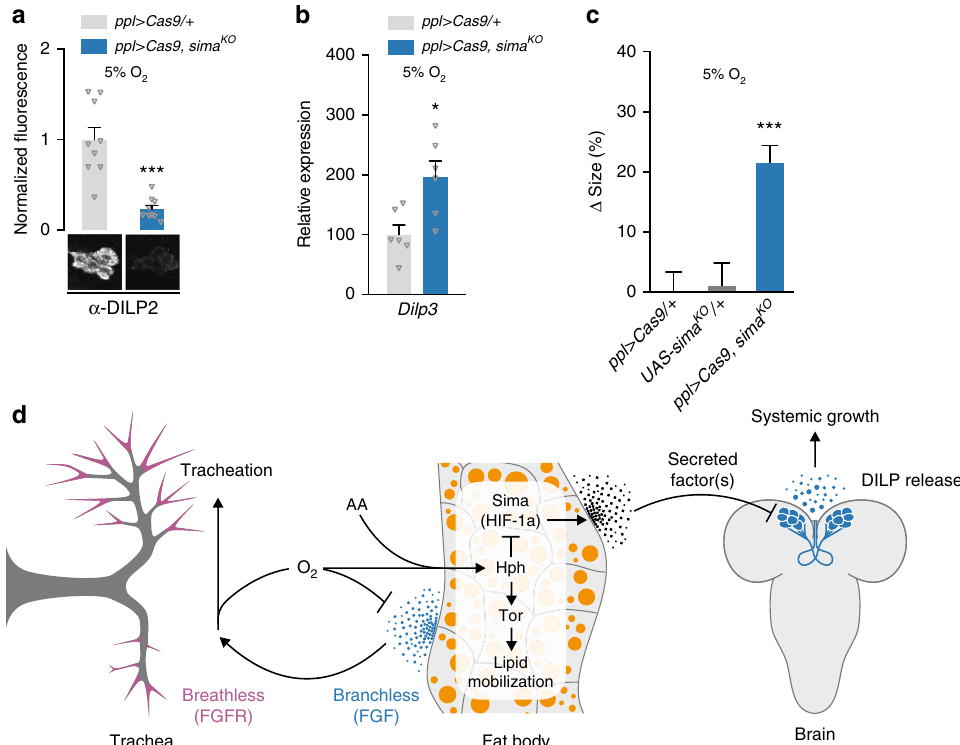
Fig. 8 HIF-1a/Sima is required in the fat body for hypoxia-induced growth suppression. a – c Fat-body-speci fi c loss of sima via tissue-speci fi c CRISPR/Cas9- mediated gene disruption reduces hypoxia-induced IPC DILP2 retention ( a ) and suppression of Dilp3 expression ( b ) and rescues hypoxia-induced growth restriction ( c ). Statistics: Student ’ s t -test for pairwise comparisons and one-way ANOVA with Dunnett ’ s for multiple-comparisons test. * P < 0.05, *** P < 0.001, compared with controls ( ppl > Cas9/ + and UAS-sima KO / + ). Error bars indicate SEM. Underlying data are provided in the Source Data fi